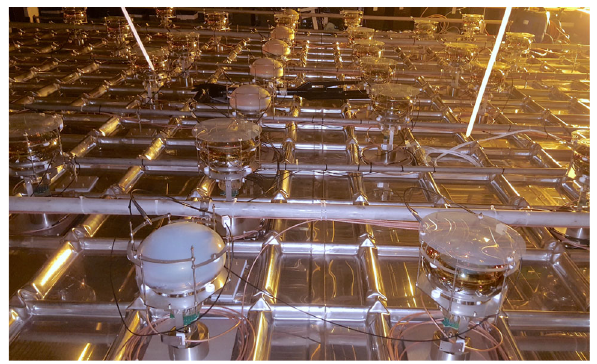
Fig. 2 ProtoDUNE-DP PDS formed of 36 PMTs installed at the bot- tom of the cryostat at CERN. The front left PMT has TPB coating and the front right PMT has PEN